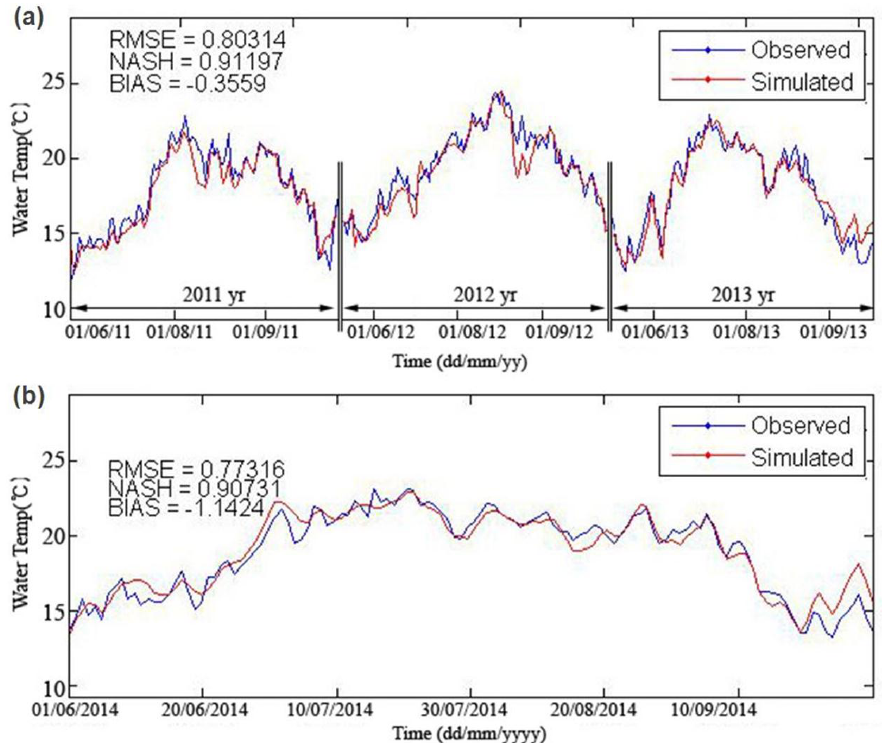
Figure 5. Observed and simulated water temperature during summer season with CEQUEAU hydrological model: (a) calibration (June to September 2011 to 2013); and (b) validation periods (June to September 2014).